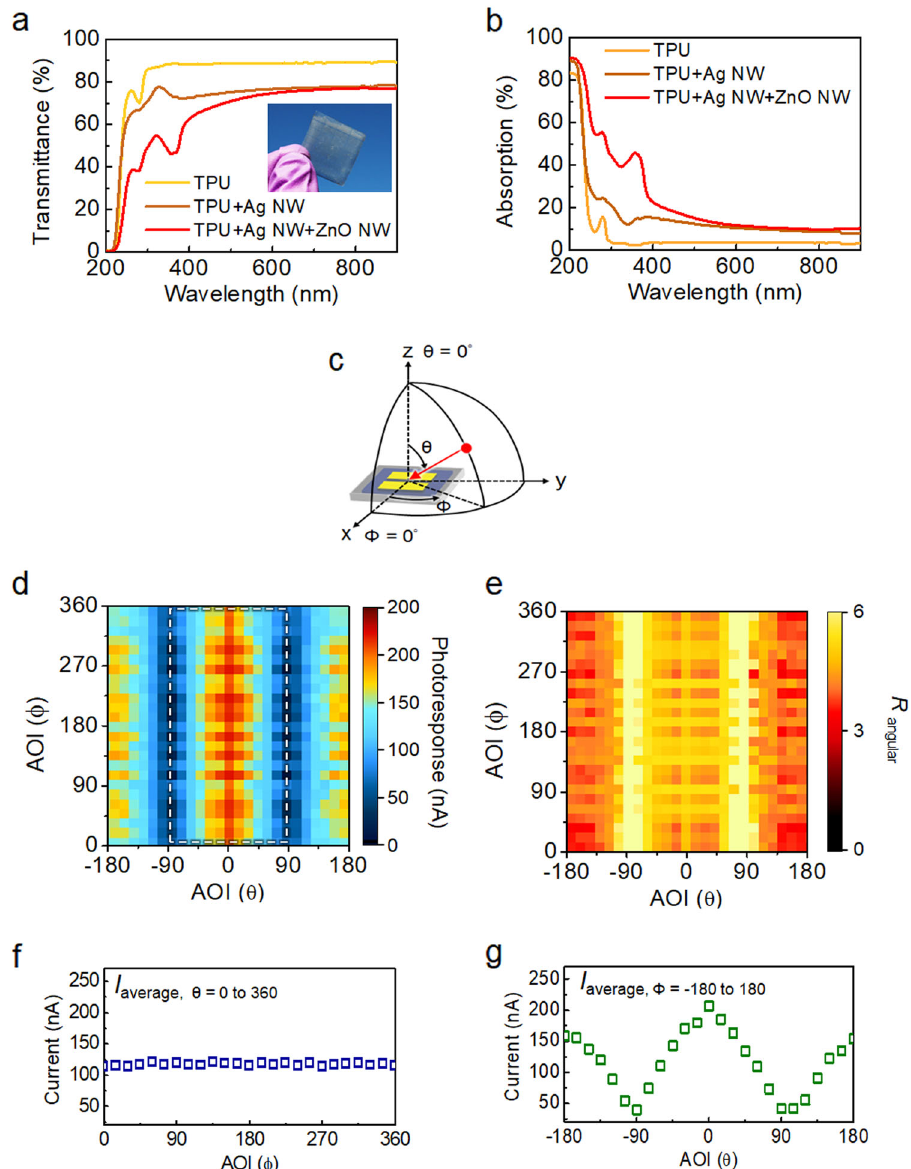
Fig. 3 a The transmittance and ( b ) absorption spectra of the different components of the PD device, including the TPU, Ag and ZnO NWs. c An illustration of the spherical coordinate system used in this study. d The photocurrent measured at different angles of incidence (AOI). e R angular ( θ , φ ) extracted from ( d ). f The photocurrent along θ , in which each point is the average photocurrent from φ = 0° to φ = 360°. g Photocurrent along φ , in which each point is the average photocurrent from θ = − 180° to θ = photoresponse exhibited negligible changes, in which the bending the TPU substrate along the lateral (x axis) and photocurrent decreased by 8 and 7% while bending the PD longitudinal (y axis) directions of the active ZnO NW channels. A device along the x and y, respectively axes (bending radius = 365 nm wavelength UV lamp illuminated the device from the top 5 mm). position ( θ = 0°). Our results show the PD is capable of stretching To examine the stability of the device, we measured the and bending while retaining the photocurrent (Fig. 4c, d). As we retention of photodetectivity after repeatedly deforming the applied 60% strain to the PD along the perpendicular direction device. After stretching for 100 cycles at 60% strain, the relative to the active ZnO NW channels, the photocurrent photocurrent retained 95 and 84% of its original value along the decreased by only 9%, which we attributed to the fi rm interlacing x and y axes, respectively (Fig. 4e). Note that we observed no of the Ag and ZnO NW networks in the TPU substrate. These NW permanent degradation of the device ’ s photodetective character- networks help to retain the ef fi cient transport of the photo- istics after relaxation of the strain, indicating that the slight generated carriers even under high deformation of the device due detachment of the NW network is recoverable. In addition, the to the high number of intersecting Ag and ZnO components. photocurrent maintained 98 and 94% of its original value after However, when we stretched the device by 60% along the axis of bending the device for 100 cycles (bending radius = 5 mm) along the ZnO channels, the photocurrent decreased by 46%, possibly the x and y axes, respectively (Fig. 4f). The excellent repeatability due to the slight detachment of the NWs. In the bending test, the